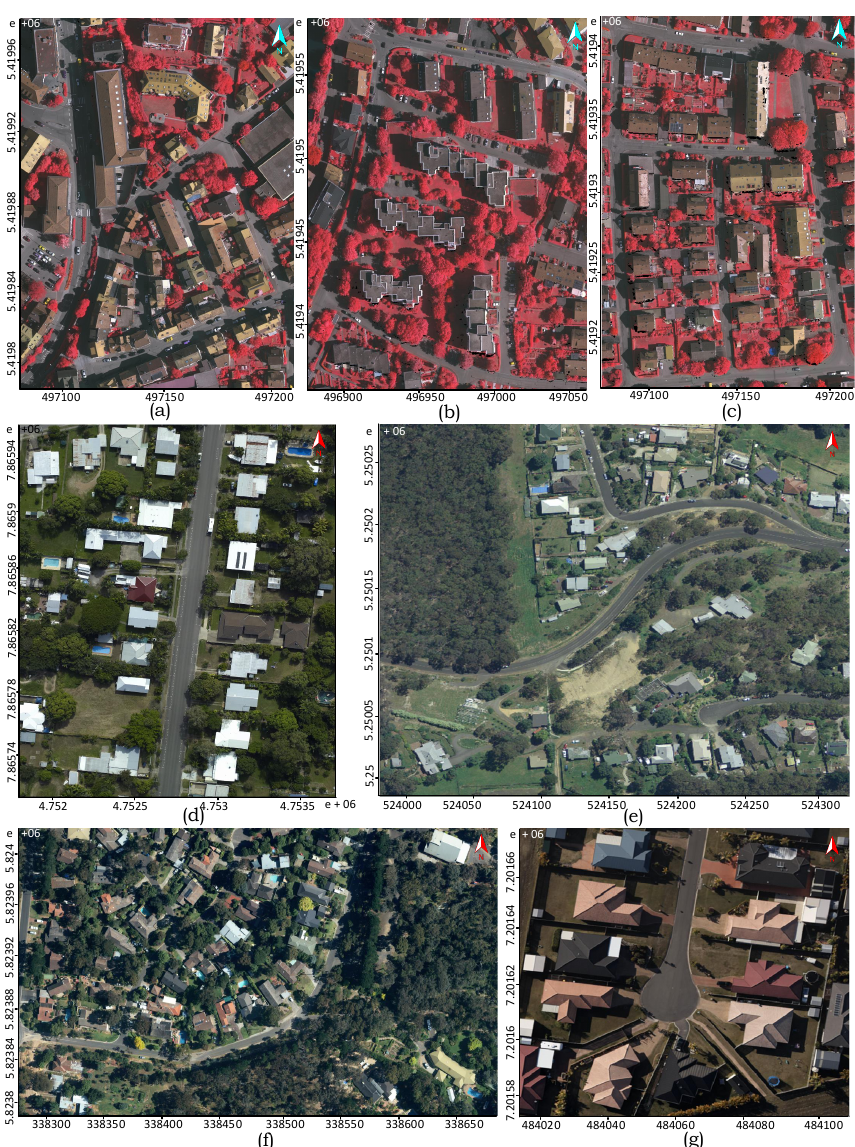
Figure 12. Data sets: Vaihingen; ( a ) Area 1; ( b ) Area 2; and ( c ) Area 3; ( d ) Aitkenvale; ( e ) Hobart; ( f ) Eltham; and ( g ) Hervey